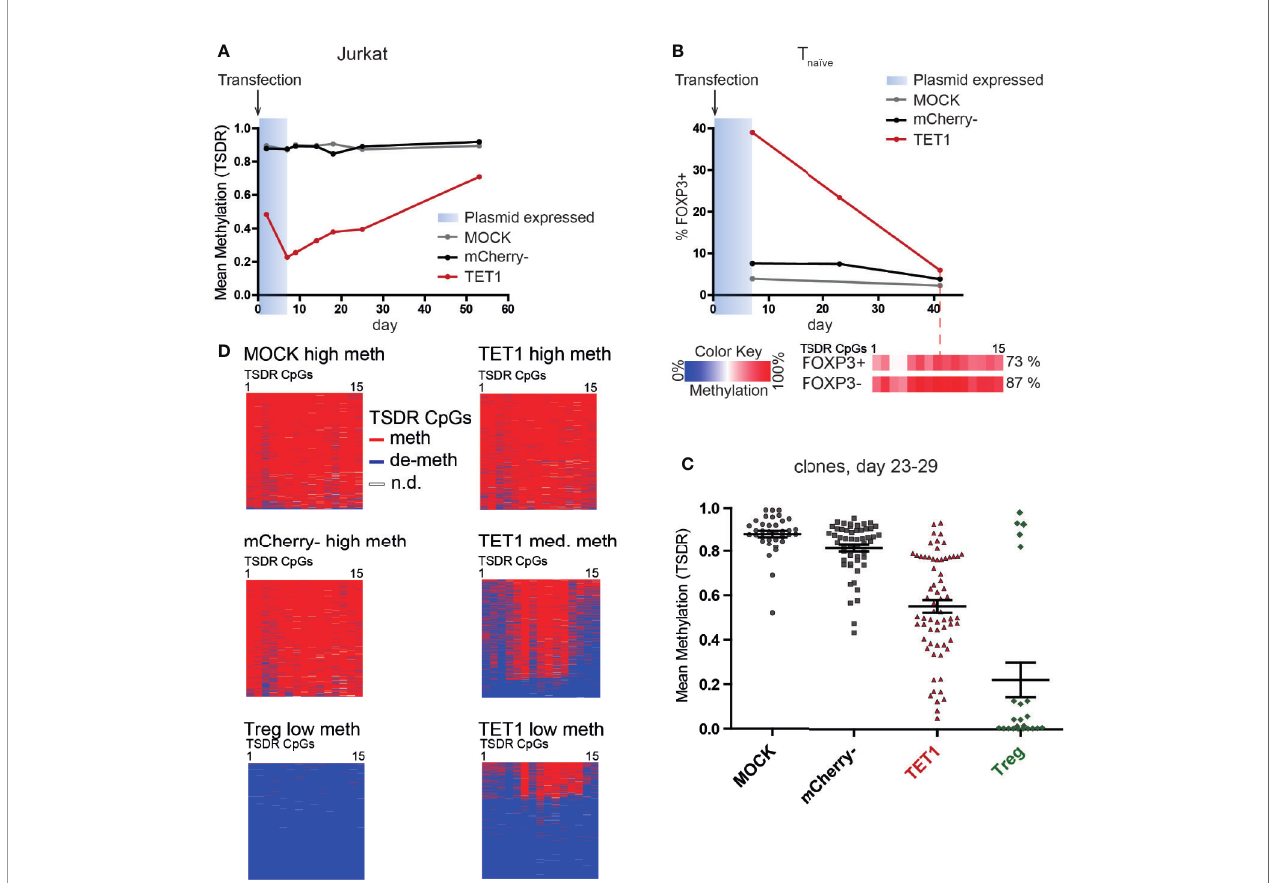
FIGURE 4 | Ef fi cient TSDR de-methylation can be stably maintained during proliferation even after expression of dCas9-TET1CD has ceased. (A) Kinetics of TSDR methylation in TET1, mCherry-, and MOCK Jurkat cells. Jurkat cells were analyzed for TSDR methylation at the indicated time-points post transfection (shown is one representative experiment of two). The estimated time-frame of dCas9-TET1CD plasmid expression is indicated in blue. (B) Samples of TET1, mCherry-, and MOCK naïve T cells were analyzed for FOXP3 expression at several time-points post transfection (shown is one representative experiment of two). The estimated time-frame of dCas9-TET1CD plasmid expression is indicated in blue. On day 42, the TSDR methylation level in the remaining FOXP3+ and FOXP3- fraction was analyzed (methylation levels for each CpG are indicated in boxes according to the color scale). The mean TSDR methylation level is indicated in percent. (C) On day 2 post transfection, single cells of TET1, mCherry-, and MOCK naïve T cells and untreated Tregs were resorted from each group as founder cells for clonal cultures. TSDR methylation levels of the grown clonal cultures 23 – 29 days post transfection were analyzed. Each dot represents a clonal culture, the mean and SEM are indicated. Pooled results from 2 independent experiments are shown. (D) The TSDR methylation patterns obtained from Amplicon-seq for selected examples of the generated clones in C are shown. The results are shown for each analyzed read (lines) and each of the 15 TSDR CpG within the Amplicon